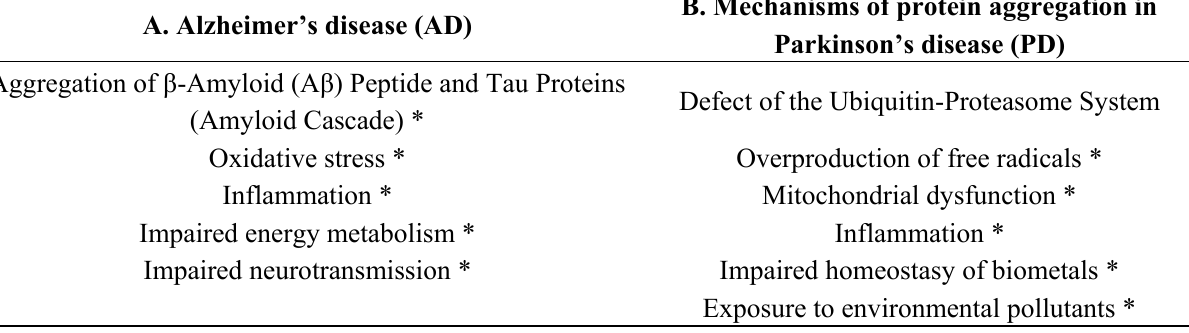
Table 2. Pathogenic mechanisms of Alzheimer’s disease (AD, left) and mechanisms of protein aggregation in Parkinson’s disease (PD,